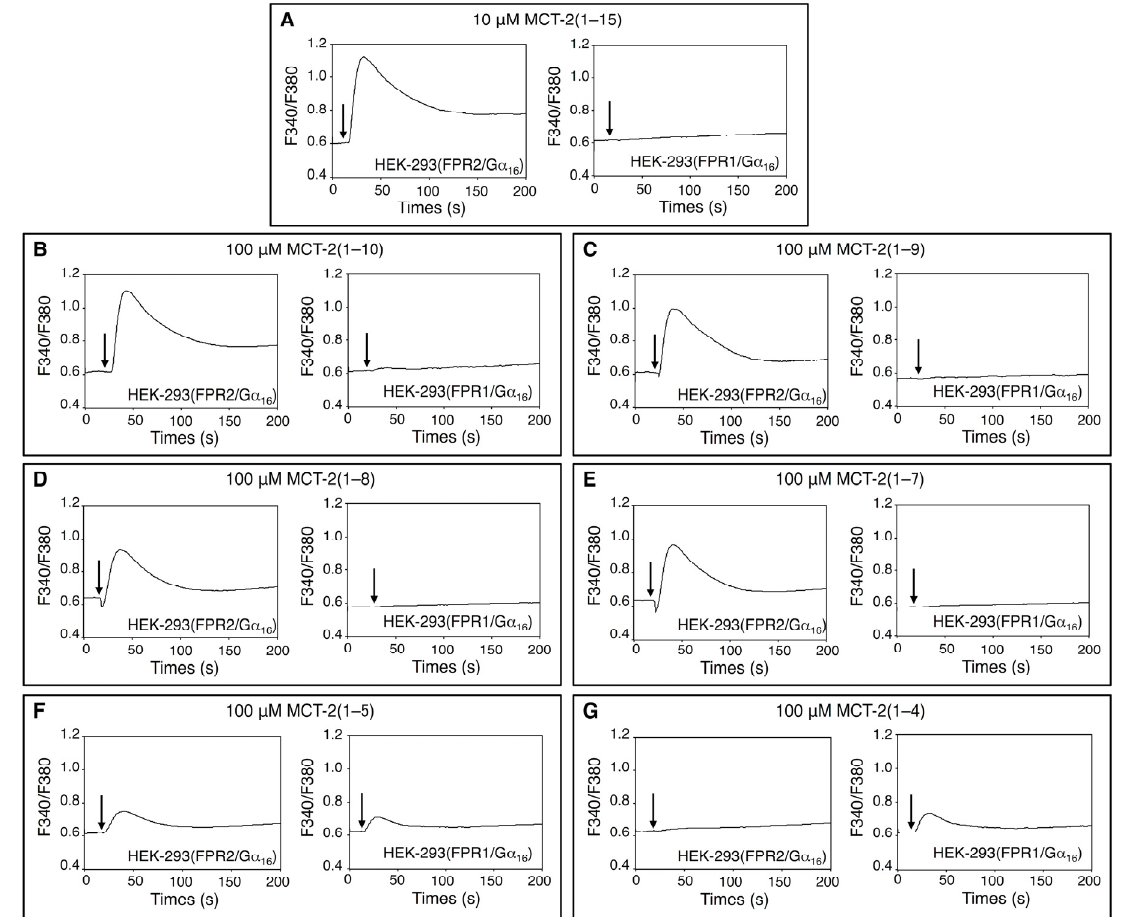
Figure 1. Changes in [Ca 2+ ] i in HEK-293 cells stably expressing FPR1 (formyl peptide receptor 1) or FPR2 (formyl peptide receptor 2) induced by MCT-2 (Mitocryptide-2)(1–15) and its derivatives. Fura-2-loaded cells were stimulated with 10 µ M MCT-2(1–15) ( A ) or 100 µ M MCT-2(1–10) ( B ), MCT-2(1–9) ( C ), MCT-2(1–8) ( D ), MCT-2(1–7) ( E ), MCT-2(1–5) ( F ), and MCT-2(1–4) ( G ). The changes in the fluorescence ratio of Fura-2 (excitation wavelengths, 340 nm and 380 nm; emission wavelength, 500 nm) were recorded by a fluorometer CAF-100. Horizontal axes show the times after stimulation. Vertical axes depict the fluorescence ratios at excitation wavelengths of 340 nm and 380 nm. Arrows indicate the timing of peptide administration.